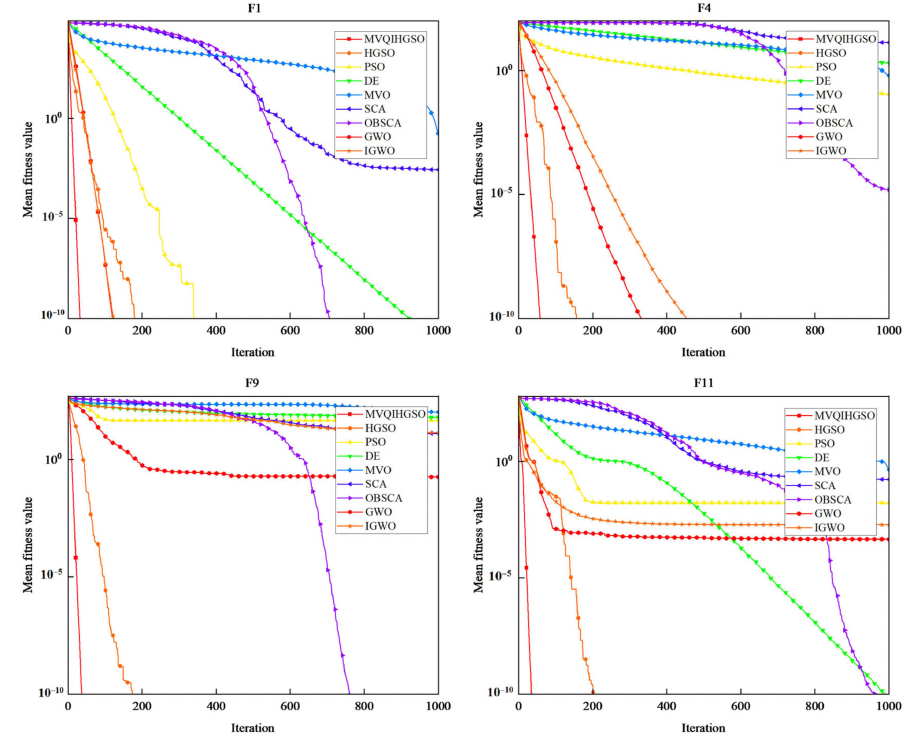
Figure 2. Convergence curves of algorithms for F1, F4, F9, and